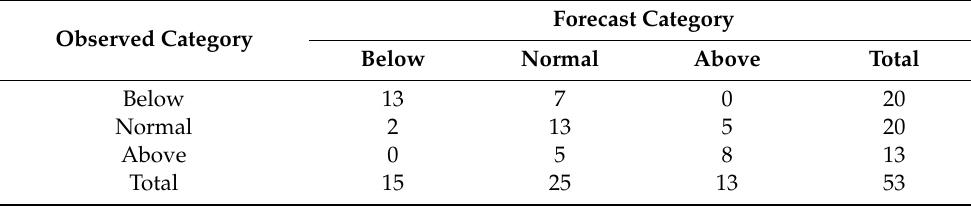
Table 6. Contingency table of the comparison between the forecasts and observations in May.